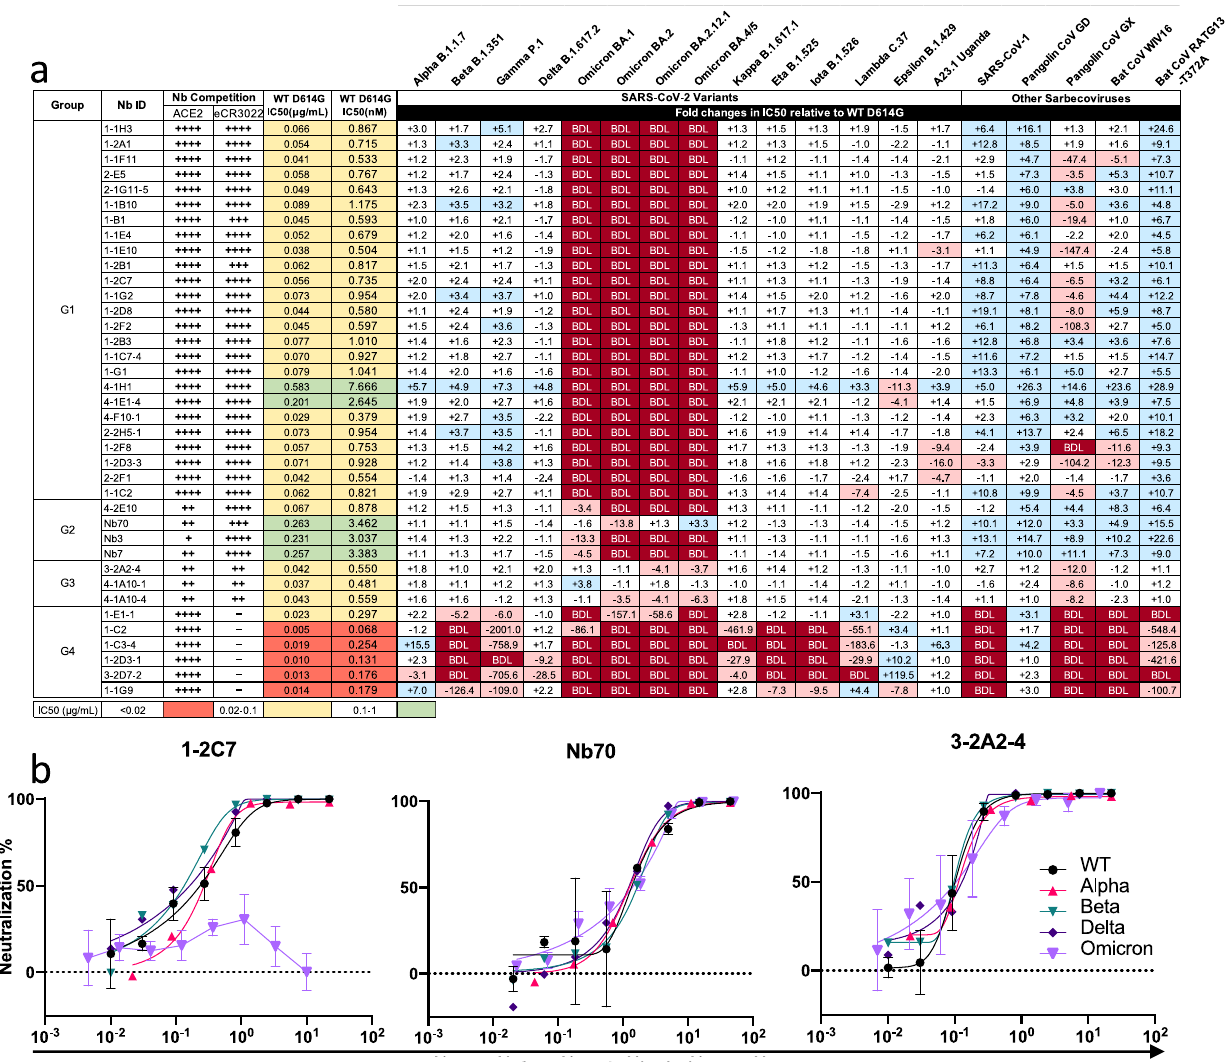
Fig. 2 | Classi fi cation and neutralizing activity of isolated nanobodies against SARS-CoV-2 variants and diverse hACE2-dependent sarbecoviruses. a Classi fi cation of nanobodies into four major groups based on their degrees of competition with ACE2 and control eCR3022 antibody with known epitope spe- ci fi city, measured by surface plasmon resonance (SPR). “ ++++ ” indicates >90% competition, “ +++ ” 60-90%, “ ++ ” 30-60%, “ + ” 10-30%, and “ - ” no detectable com- petition. Neutralizing activities of nanobodies in the Fc format against WT D614G were presented by IC50 ( μ g/mL and nM) while that against SARS-CoV-2 variants and hACE2-dependent sarbecoviruses were in fold-changes relative to that of WT D614G. IC50 values highlighted in salmon indicate <0.02 μ g/mL; in yellow 0.02- 0.1 μ g/mL, and in green >0.1 μ g/mL. “ - ” indicates increased resistance and “ + ”